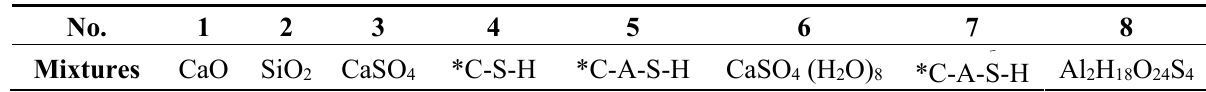
Table 4. XRD patterns of the mixture CF co-firing fly ash and GGBS. (CF: fly ash CF, GGBS: ground granulated blast-furnace slag) No. 1